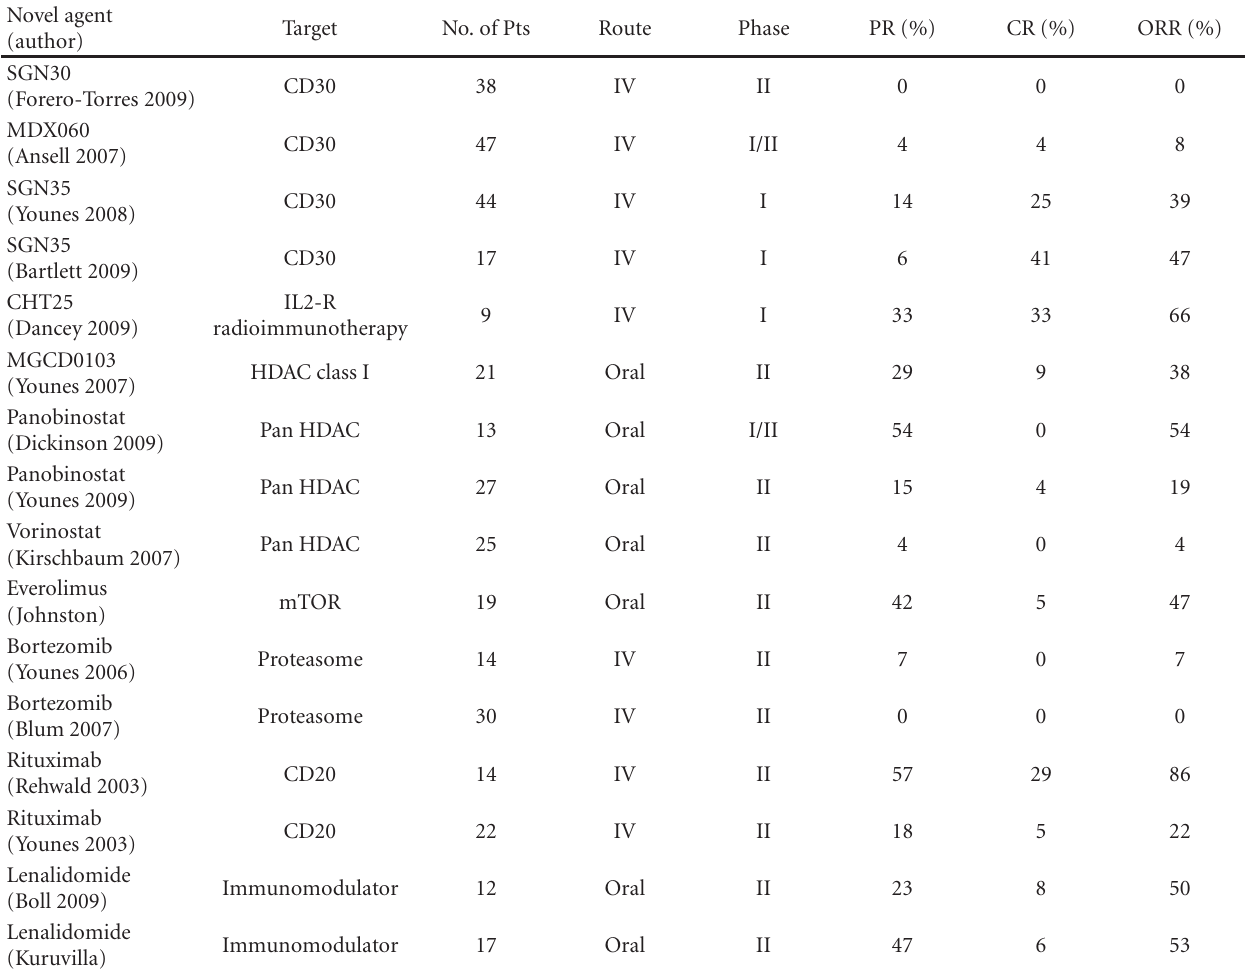
Table 10: Comparison of early phase studies of novel agents in relapsed and refractory Hodgkin’s lymphoma. Abbreviations: PR: partial response; CR: complete response; ORR: overall response rate; IL2-R: interleukin 2 receptor; HDAC: histone deacetylase; mTOR: mammalian target of